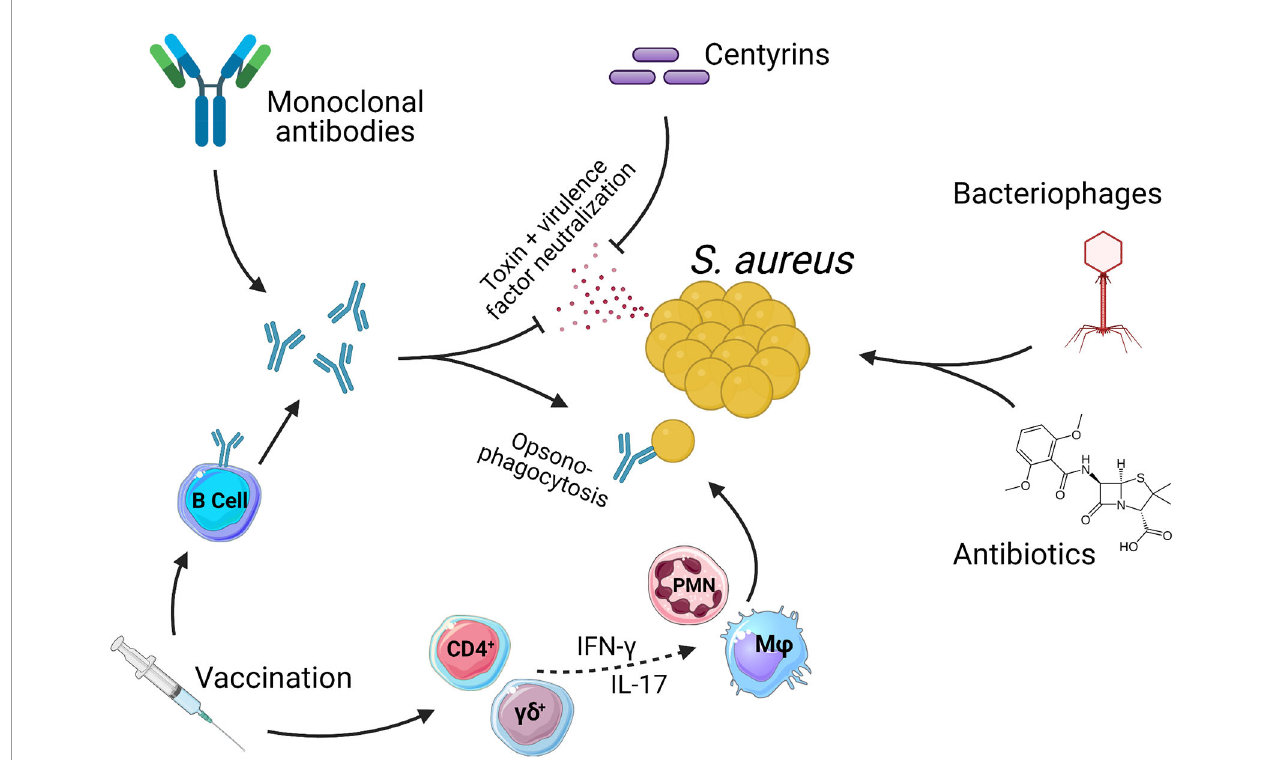
FIGURE 1 | Methods of targeting Staphylococcus aureus . There are numerous therapies being investigated as treatments for S. aureus infections. Antibiotics are currently the only option with clinical approval. Antibiotics act directly on bacteria via either bacteriostatic or bactericidal mechanisms. Bacteriophages also act directly on S. aureus to kill bacteria. Centyrins are small proteins with the ability to neutralize bacterial exo-toxins and virulence factors. Monoclonal antibodies can act in the same manner as centyrins to neutralize bacterial exo-toxins and virulence factors, with a secondary mechanism of opsonizing the bacteria due the presence of antibody Fc regions. Vaccines generate populations of memory B and T cells. B cells produce antibodies that act in the same manner as described for monoclonal antibodies. Memory T cells can also be induced which, through pro-in fl ammatory cytokines such as IFN- g and IL-17, aid in the activation and recruitment of innate effector cells such as Macrophage (M j ) and Neutrophils (PMN) which in turn kill bacteria. While CD4 + T cells have a more classical role in adaptive memory responses, there is growing evidence to suggest that gd T cells may be induced by vaccination and play a protective role during S. aureus infections (10 –